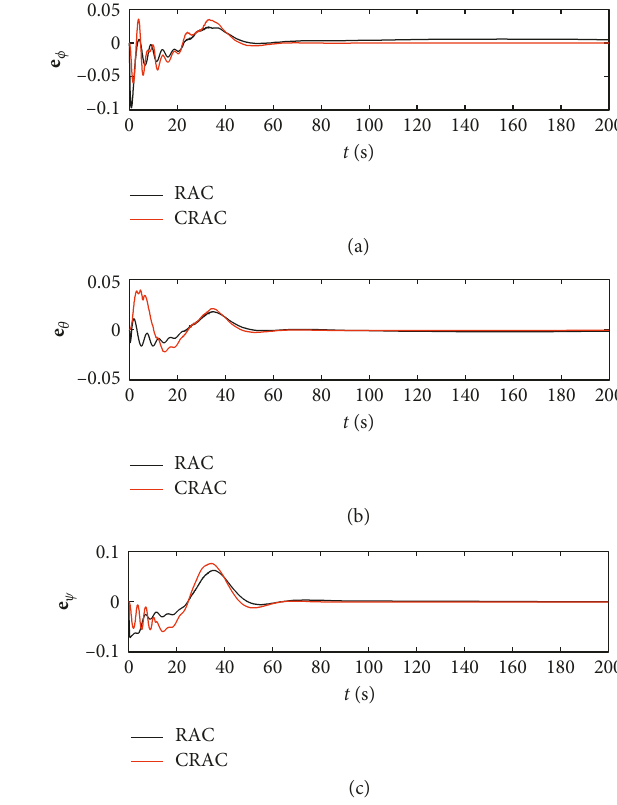
Figure 3: Time response of planned angular velocity.